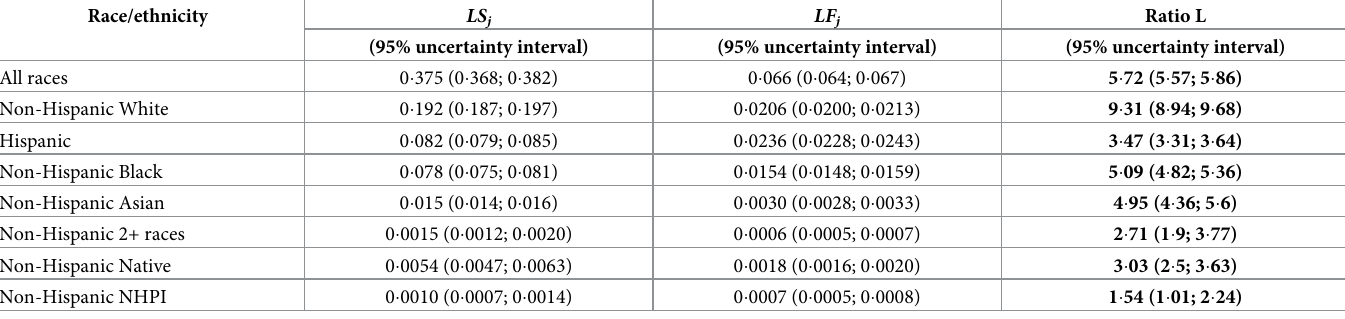
Table 3. Number of lives saved in each race/ethnicity group by vaccinating 1,000 individuals, either allocating doses to individuals 65–74 ( LS j ) or to front-line work- ers ( LF j ).